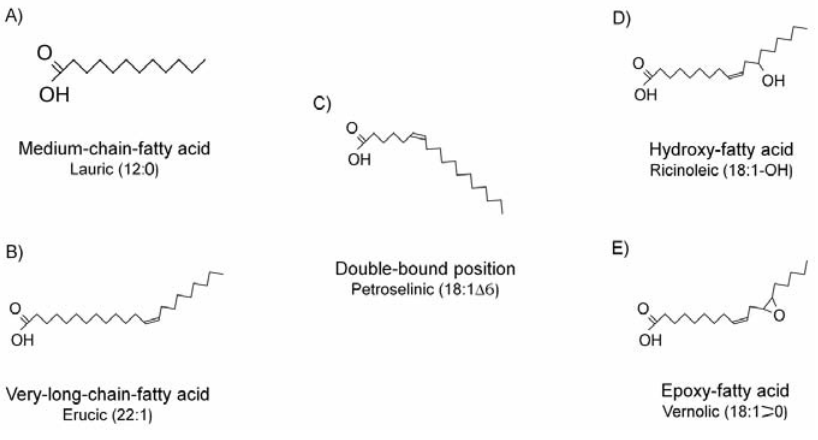
Figure 2. Examples of unusual fatty acids produced by plants. (A) Medium-chain-fatty acid. (B) Very-long-chain-fatty acid. (C) Unusual double-bound position fatty acid. (D) Hydroxy-fatty acid. (E) Epoxy-fatty